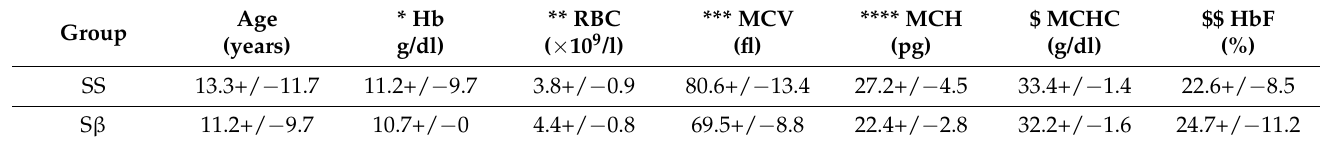
Table 3. Mean age and hematological values in HbSS- and HbS β -thalassemia patients. Age Group